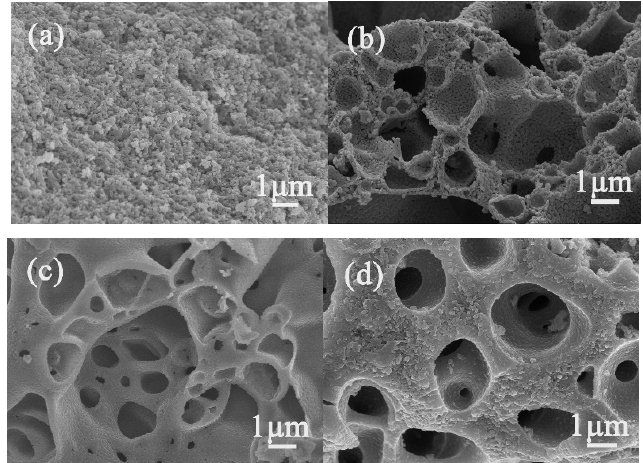
Figure 2. SEM images of the as-prepared products. ( a ) Sample CT0; ( b ) Sample CT1; ( c ) Sample CT2; ( d ) Sample CT3.